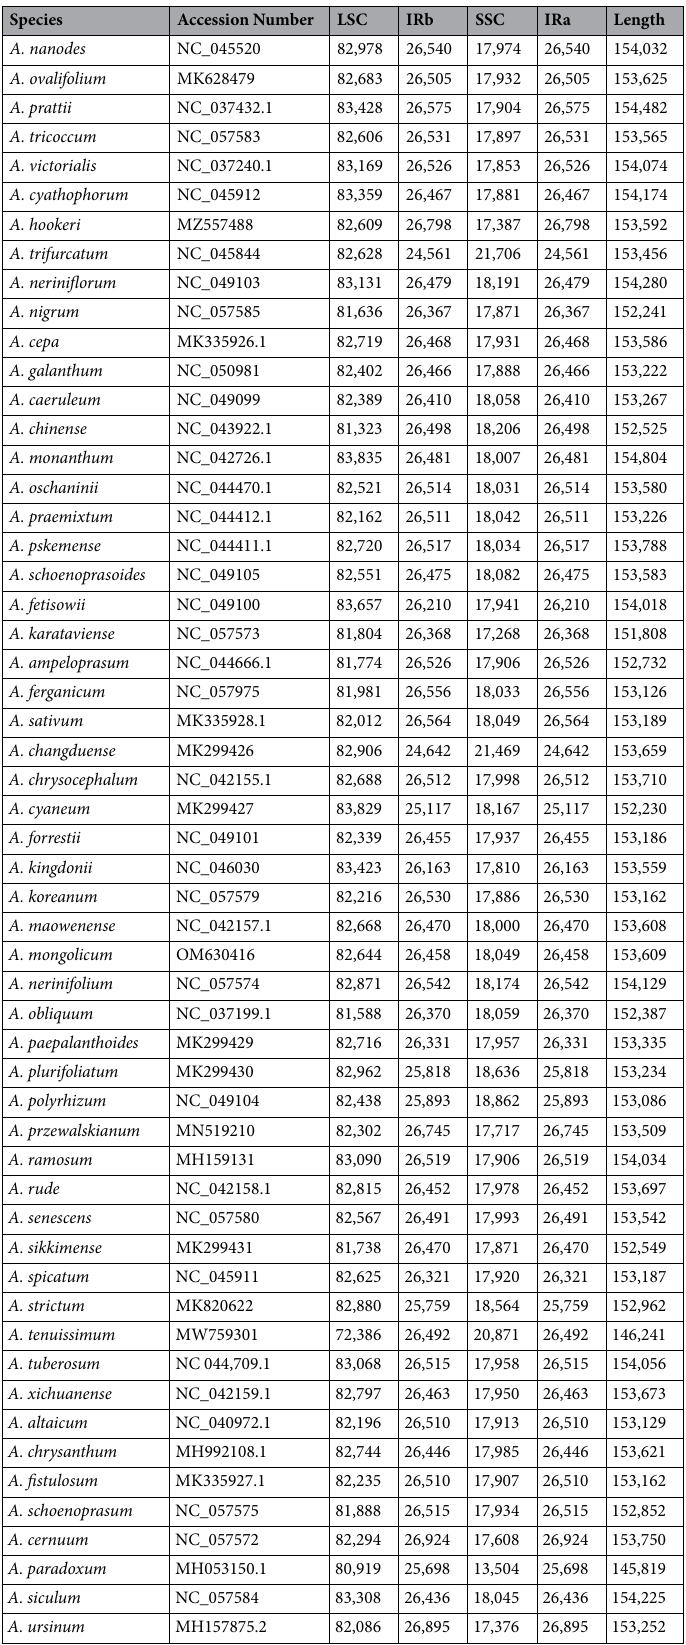
Table 2. Basic features of chloroplast genomes in